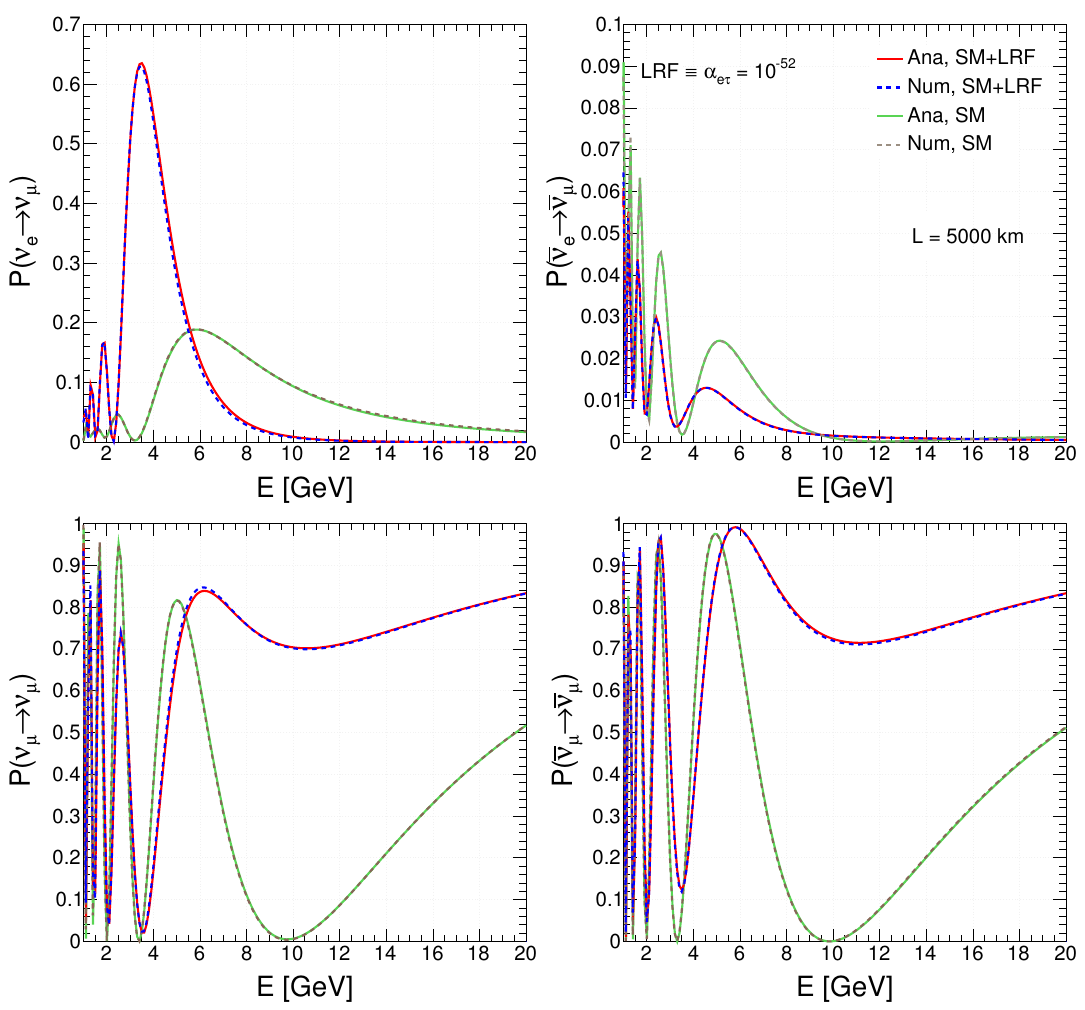
Figure 3 . (cid:23) e ! (cid:23) (cid:22) ((cid:22) (cid:23) e ! (cid:22) (cid:23) (cid:22) ) transition probability for 5000 km in upper left (right) panel assuming NH. In bottom left (right) panel, we show (cid:23) (cid:22) ! (cid:23) (cid:22) ((cid:22) (cid:23) (cid:22) ! (cid:22) (cid:23) (cid:22) ) survival probability. In all the panels, we compare our analytical expressions (solid curves) to the exact numerical results (dashed curves) for the SM and SM + LRF cases. For LRF, we consider (cid:11) e(cid:28) = 10 (cid:0) 52 . Note that the y-axis ranges are di(cid:11)erent in the upper left and right